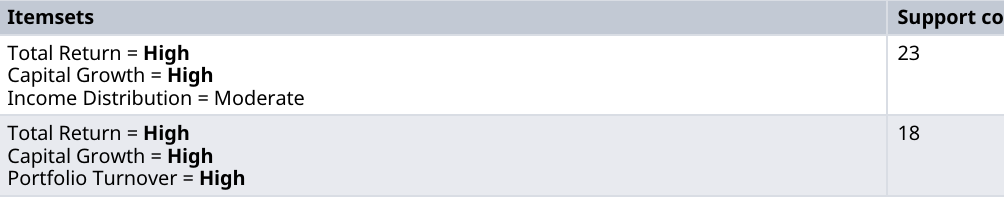
Table 3. ARM on the discretised financial data of the unit trust funds in Cluster